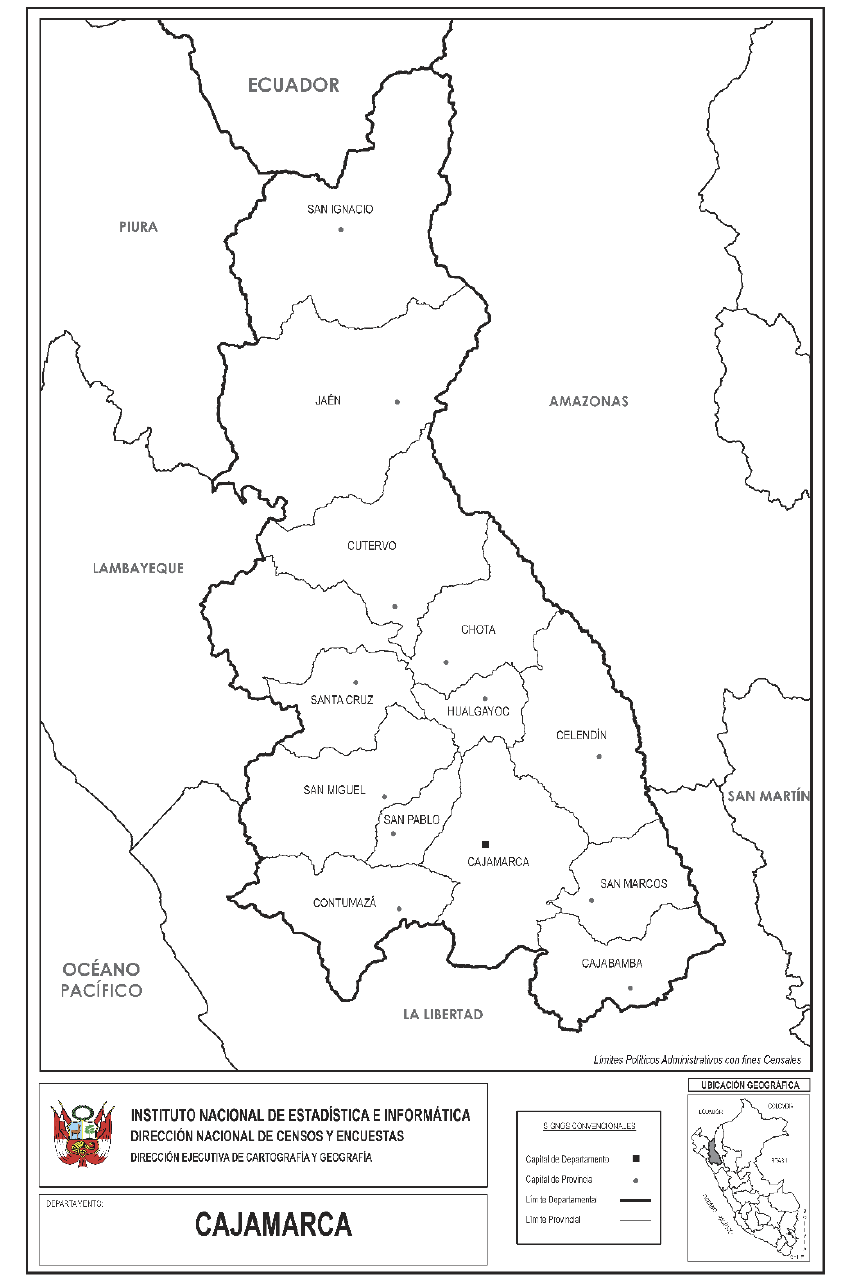
Fig. 3. View of the department of Cajamarca according to M.F. Paz Soldán and the actual department of Cajamarca (sources: David Rumsey Map Collection https://www.davidrumsey.com/luna/servlet/view/all/who/Paz+Soldan, +Mariano+Felipe,+1821-1886?os=0; INEI https://www.inei.gob.pe/media/MenuRecursivo/publicaciones_digi -